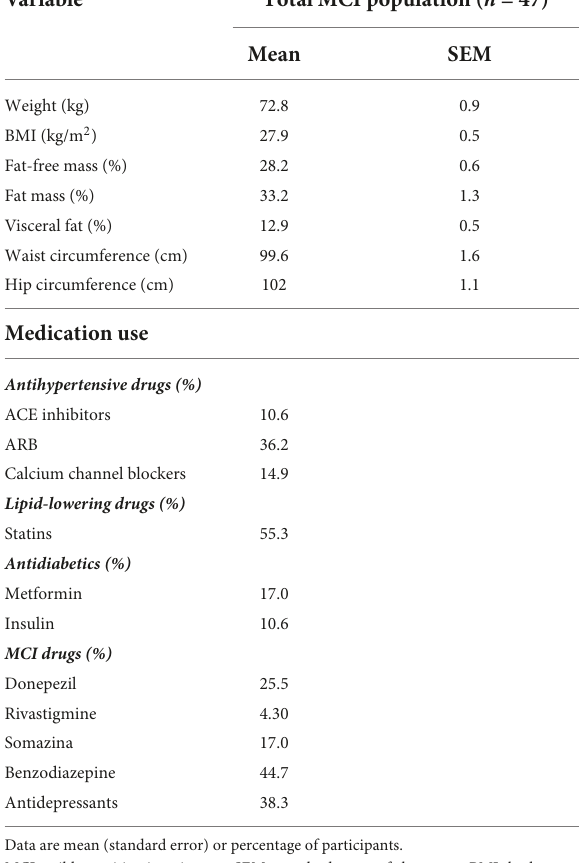
TABLE 6 Baseline values in energy and nutrient